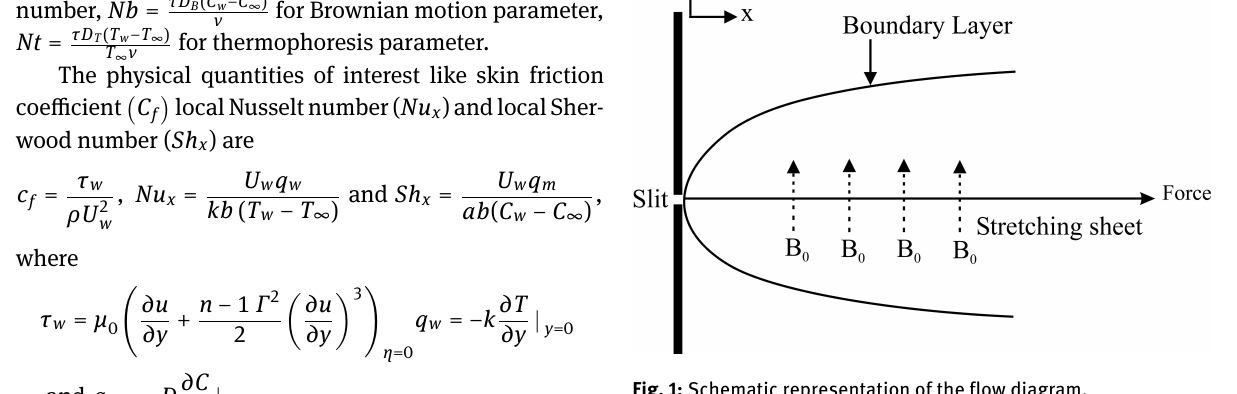
Fig. 1: Schematic representation of the flow